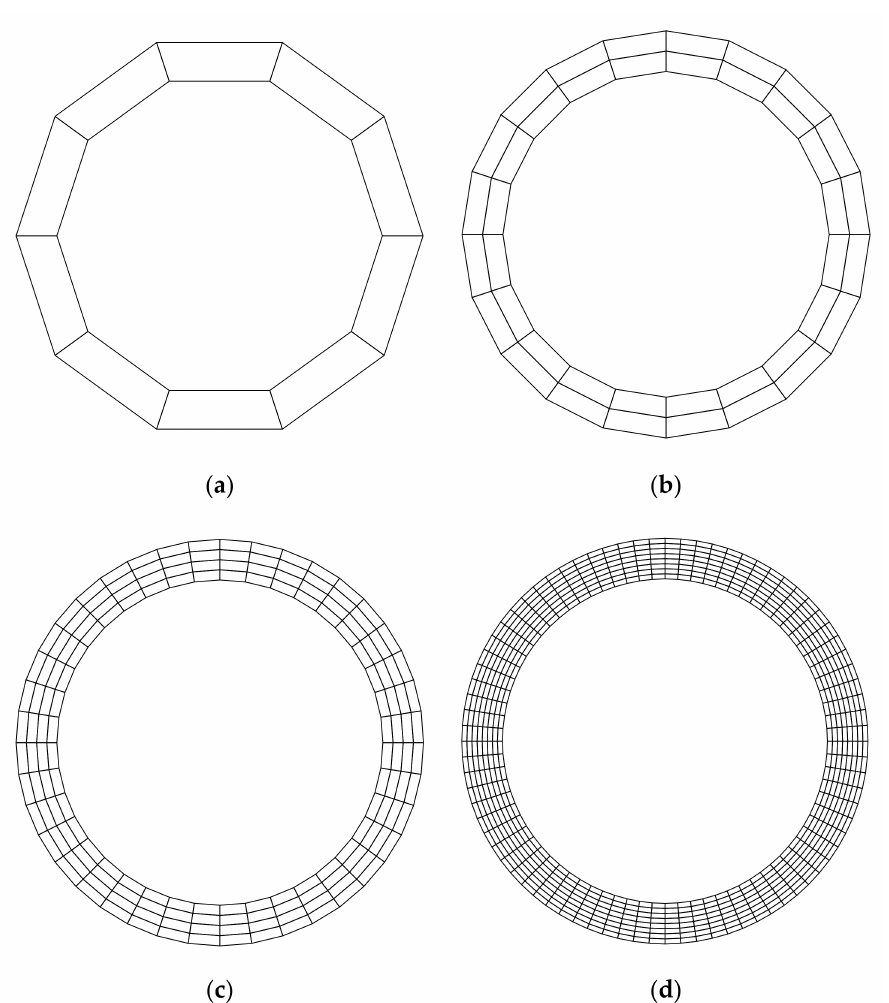
Figure 11. Quadrilaterial meshes for the annulus: ( a ) Mesh A (10 elements, 20 nodes); ( b ) Mesh B (40 elements, 60 nodes); ( c ) Mesh C (160 elements, 200 nodes); ( d ) Mesh D (640 elements, 720 nodes). In addition, FE-RPIM QUAD4 element can obtain better result if the DLMM is em- ployed instead of the